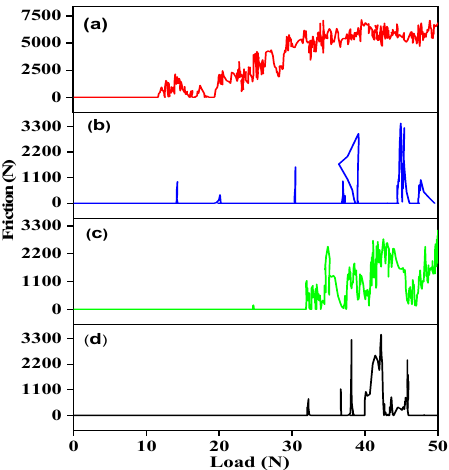
Figure 14. The analysis of critical load of the Ni-W and Ni-W/SiC composite coatings on 45 steel substrates subjected to the grit-blasting pretreatment by varying the SiC concentration in the elec- trolyte.